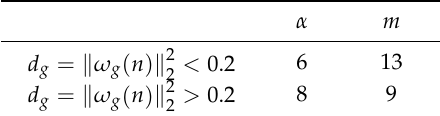
Table 2. The choose of α and m according to the value of d g